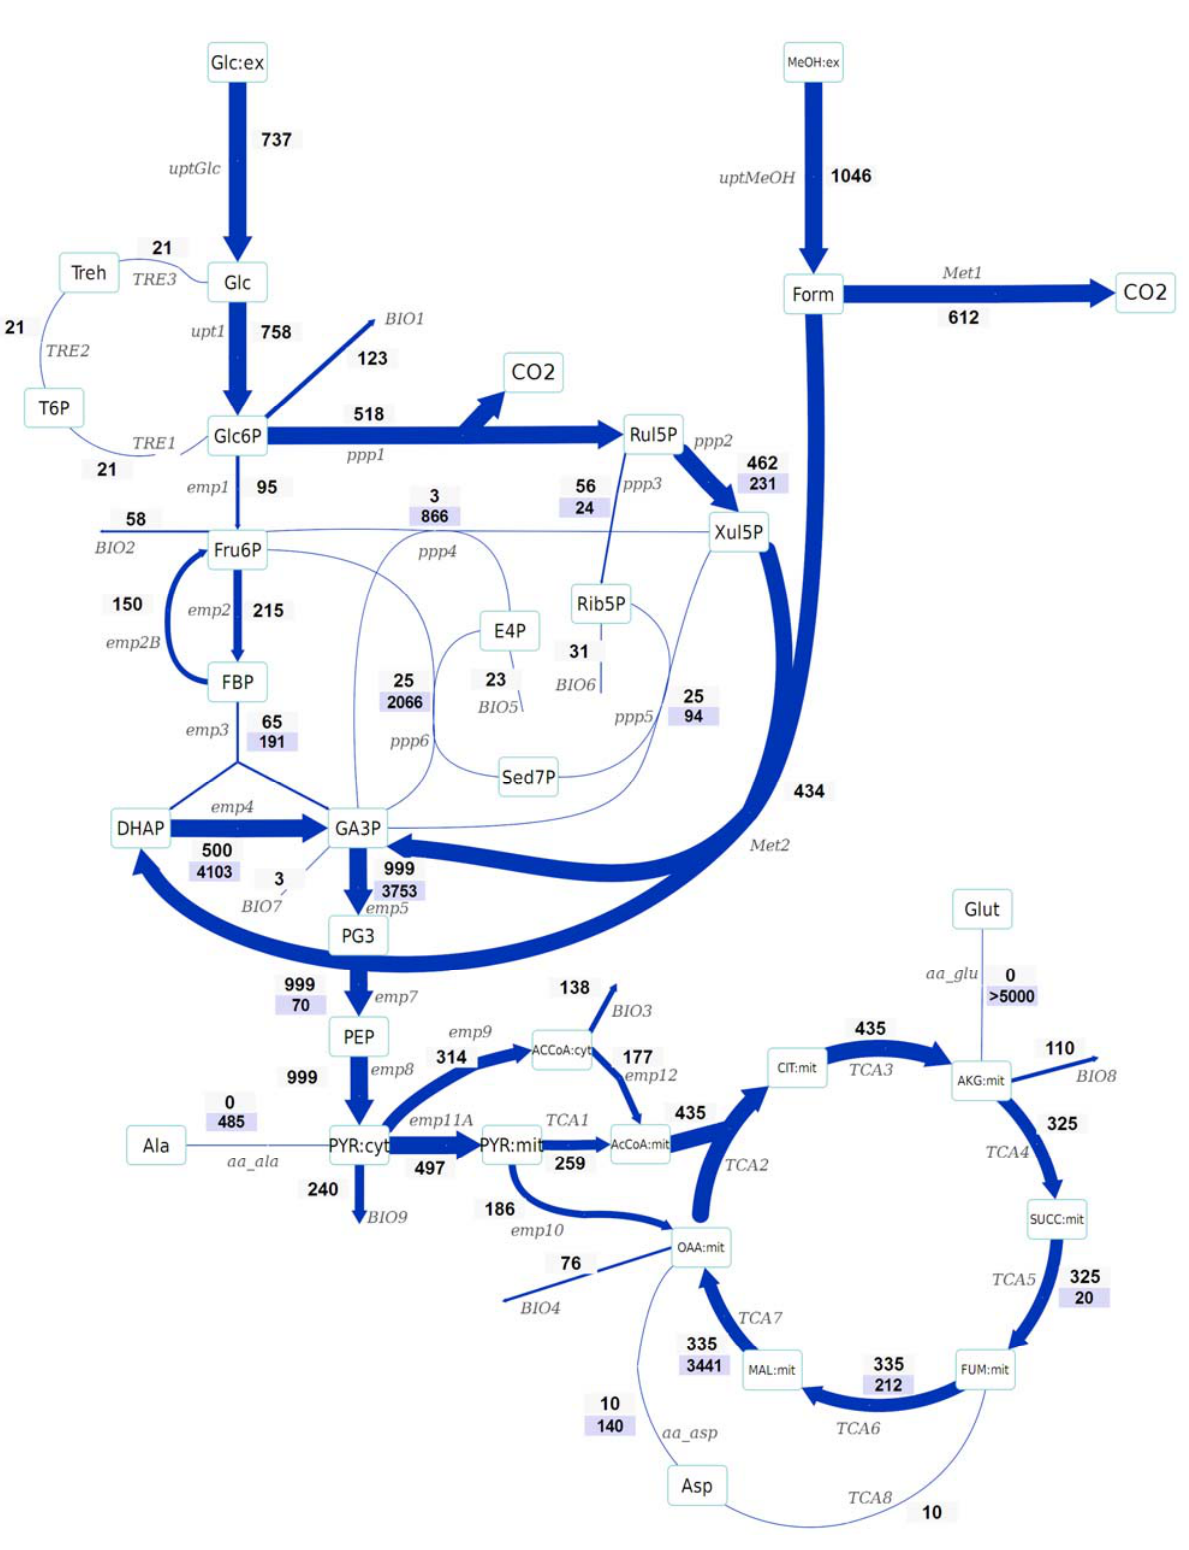
Figure 3. Metabolic flux distributions of the Rol-expressing strain based on INST- 13 C-MFA. /h. The width of the arrow represents the flux The flux values are given in  mol/g DCW value. The upper values represent the net flux (in direction of the arrow), whereas the lower values (on blue background) reflect the backward flux (absolute). All the fluxes are also listed in Supplementary File